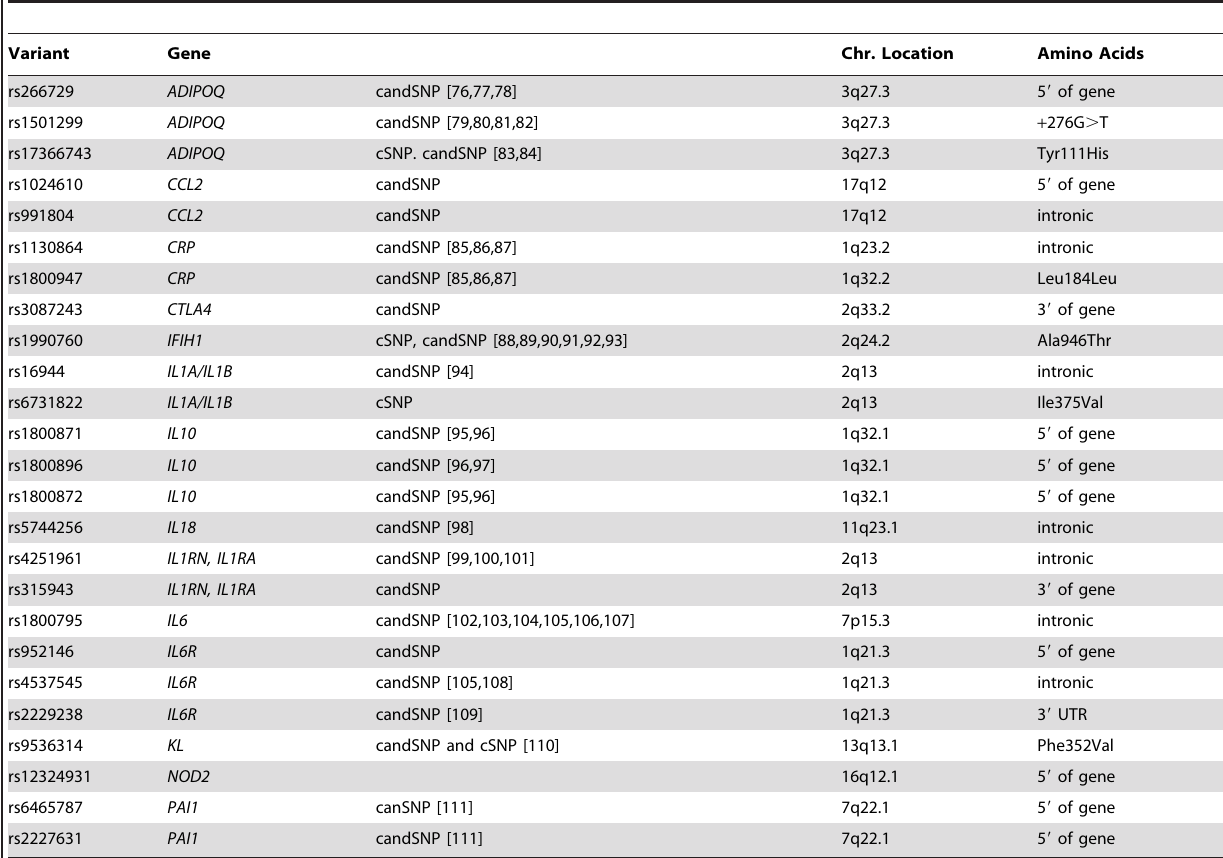
Table 3. Disease associated SNPs (candSNPs) and coding variant SNPs (cSNPs).